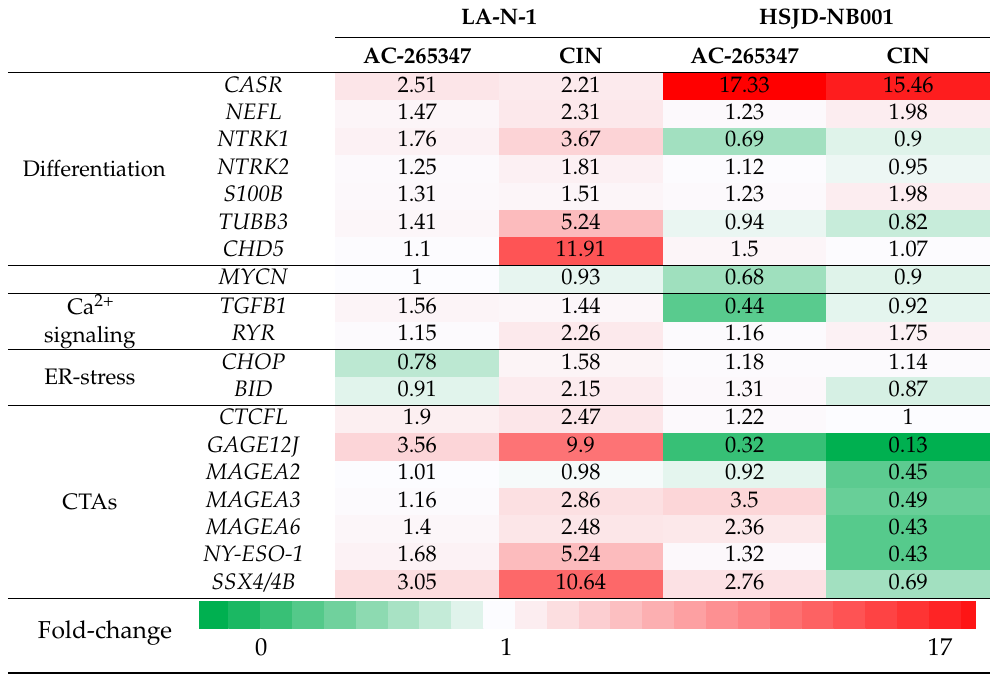
Table 1. Gene expression analyses of neuroblastoma xenografts following AC-265347 and CIN treatment conducted by RT-qPCR.